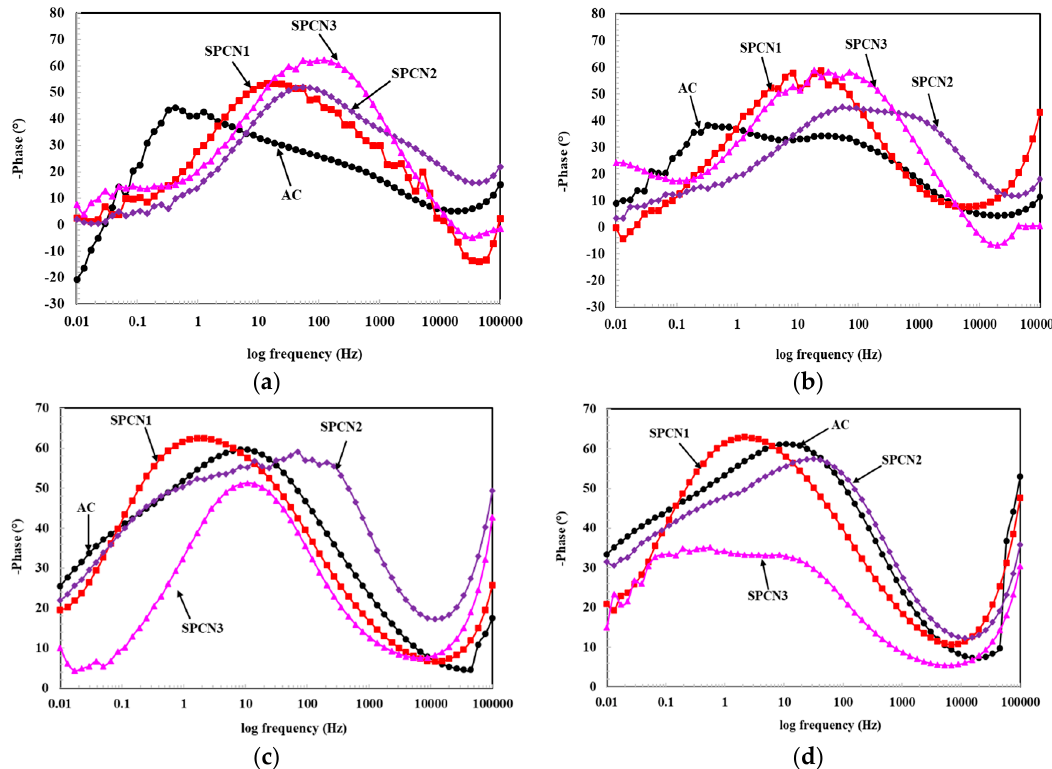
Figure 6. Phase-frequency Bode plots of coating after ( a ) 1 h, ( b ) 11 days, ( c ) 41 days, and ( d ) 89 days of exposure in 3.5 wt.% NaCl solution.